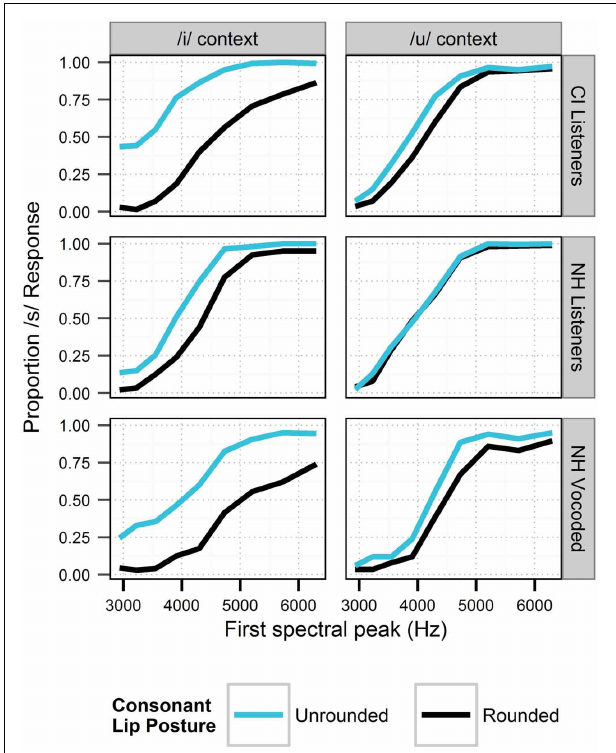
FIGURE 5 | Perception of the fricative continuum in the context of visual cues to consonant lip rounding and vowel context in Experiment 2. For each cue, responses are collapsed across all levels of the gender cues. Black lines depict cue levels expected to produce fewer /s/ responses. Sensitivity to context is demonstrated in each panel by the space between lines of different colors.